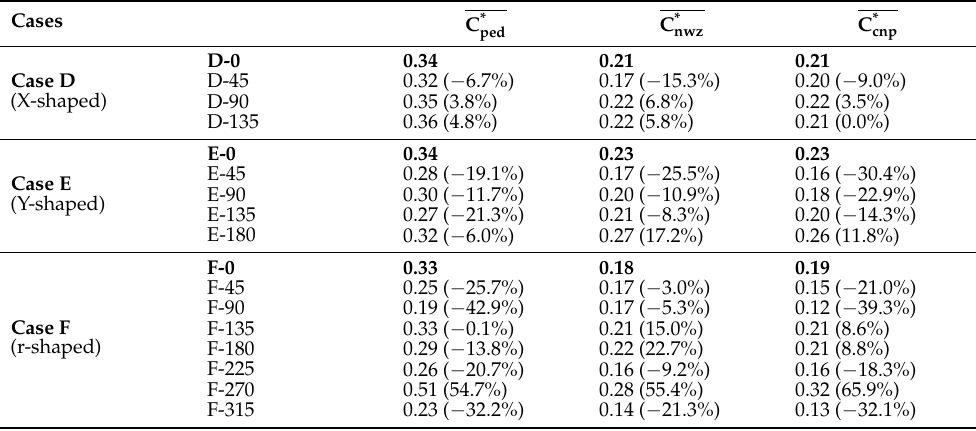
Table 2. Spatially averaged normalized pollutant concentration for the pedestrian zone (C ∗ near-wall zone (C ∗ nwz ), and the canopy layer (C ∗ cnp ) at oblique-angled intersections.